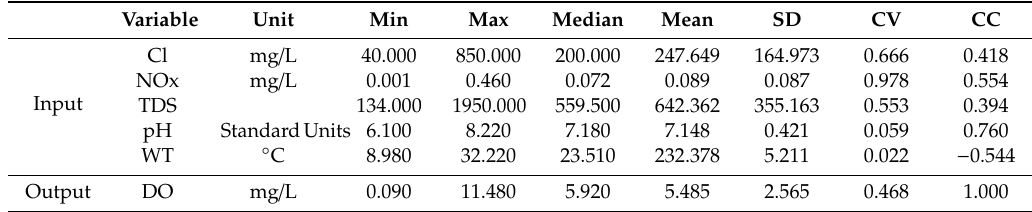
Table 1. Summary of statistics parameters of input and output variables ( n = 232).